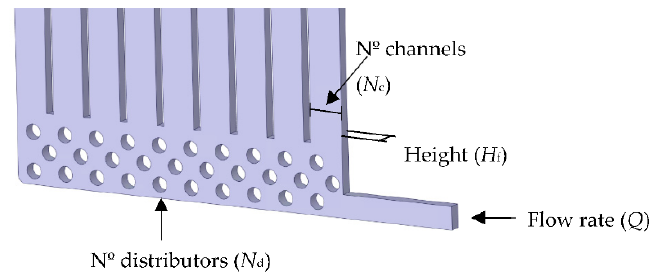
Figure 9. Parameters implemented in the optimisation process.